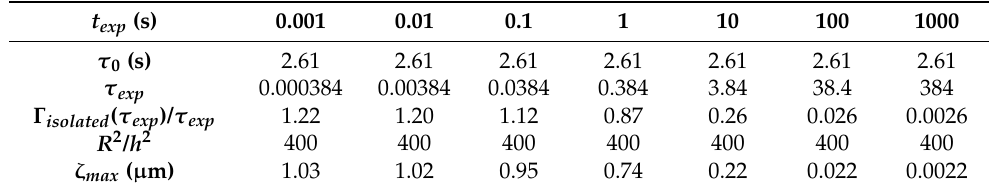
Table 6. Variation of the exposure time t exp for float glass, R = 120/2 mm and h = 3 mm.